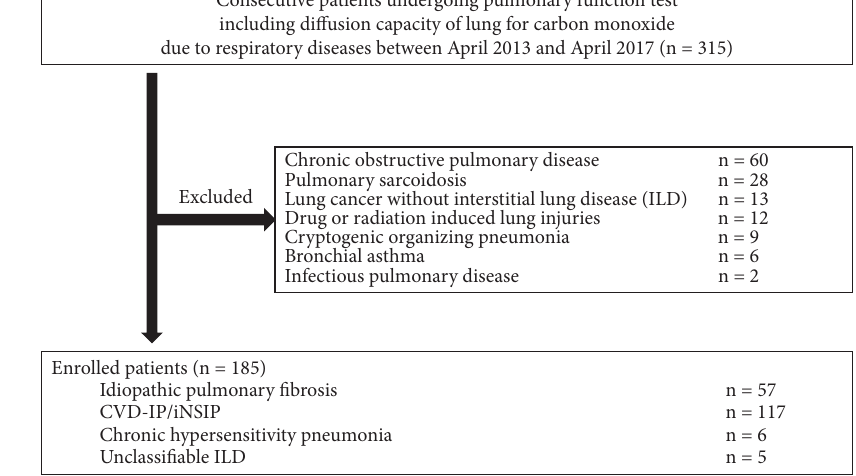
Figure 1: Flowchart of the participants’ selection process. Table 1: ILD-GAP and ILD-GAPC